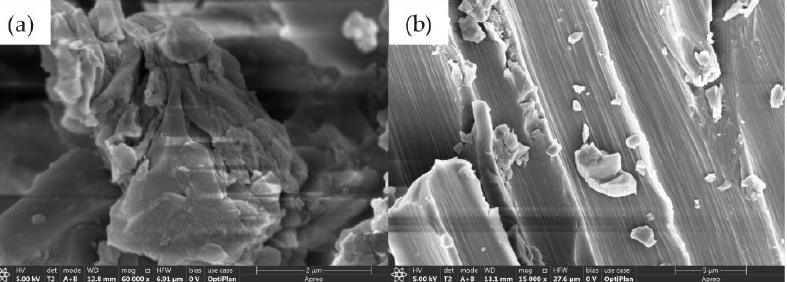
Figure 5. The SEM of GO ( a ) GO/EP composite (60,000×), ( b ) GO-CF/EP composite (15,000×).